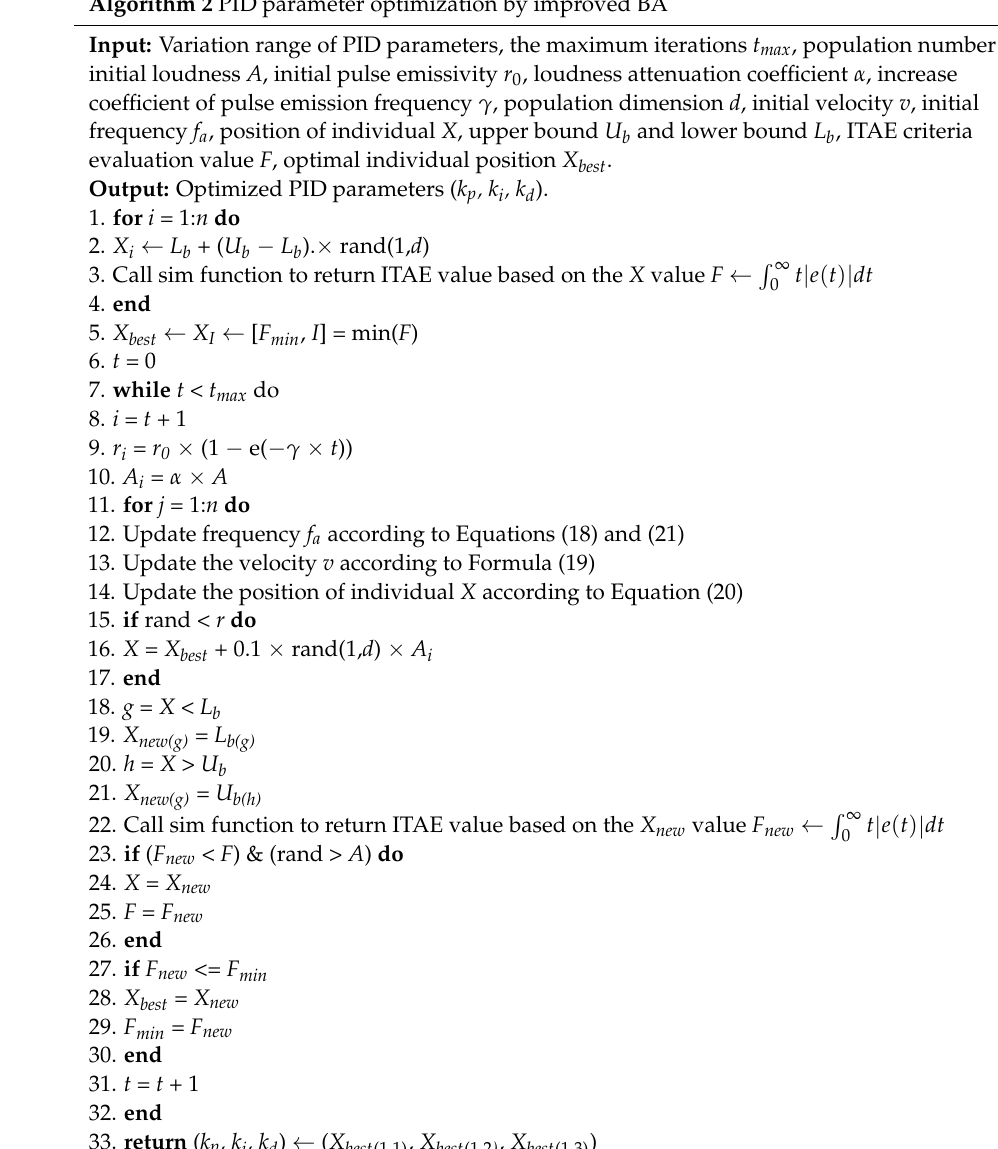
Algorithm 2 PID parameter optimization by improved